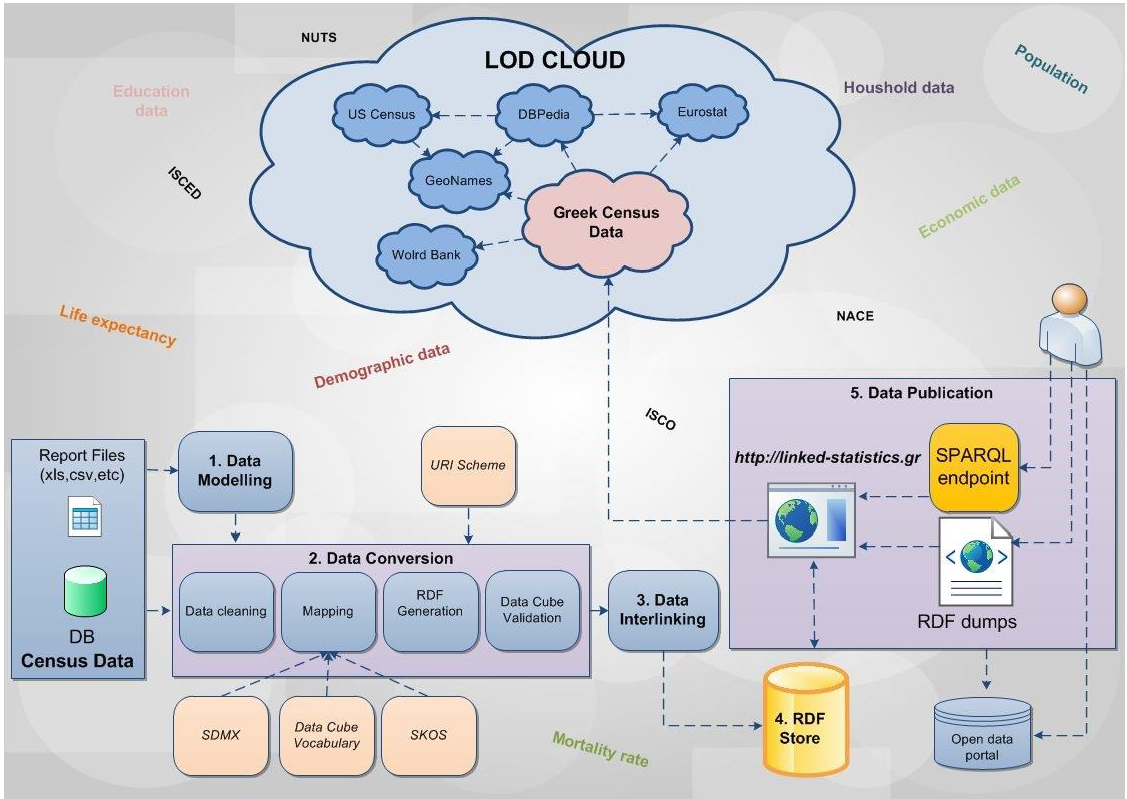
Figure 1: Publishing Statistical Data as LOD (Petrou & Papastefanatos,